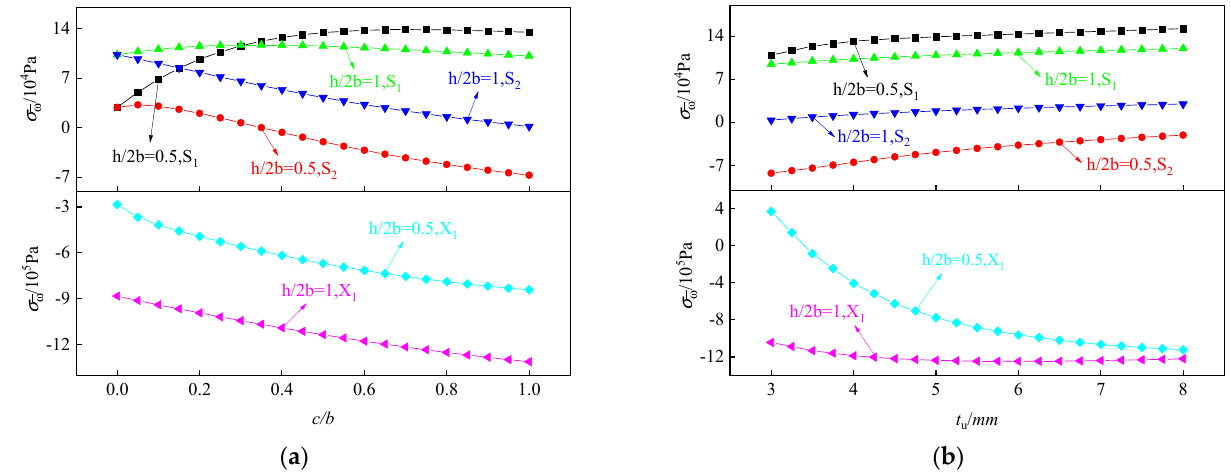
Figure 12. Torsional normal stress: ( a ) the width ratio of cantilever plate; ( b ) the thickness of bottom steel flange.